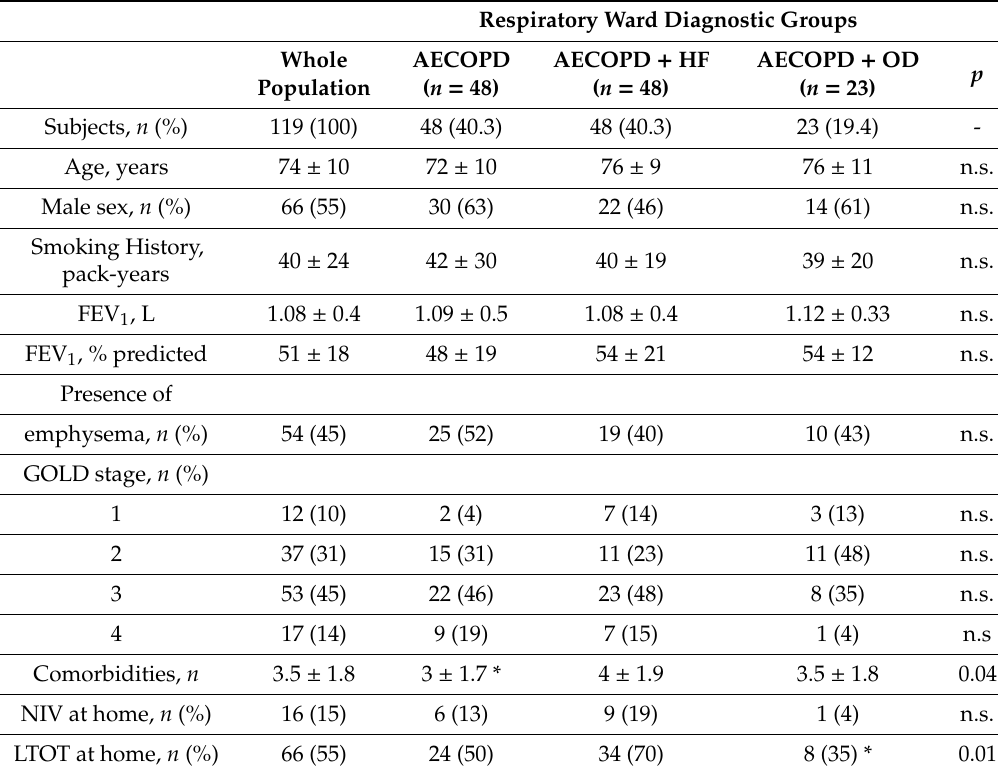
Table 1. Clinical characteristics in the whole population and in the three RW diagnostic